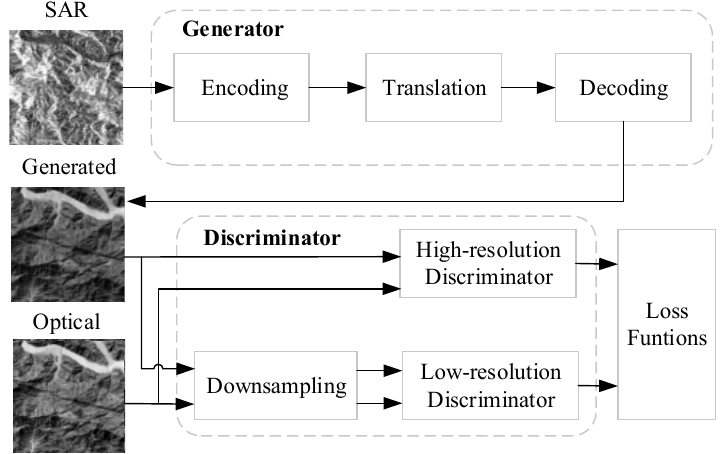
Figure 3. Architectures of the proposed synthetic aperture radar (SAR)-to-optical image translation model.